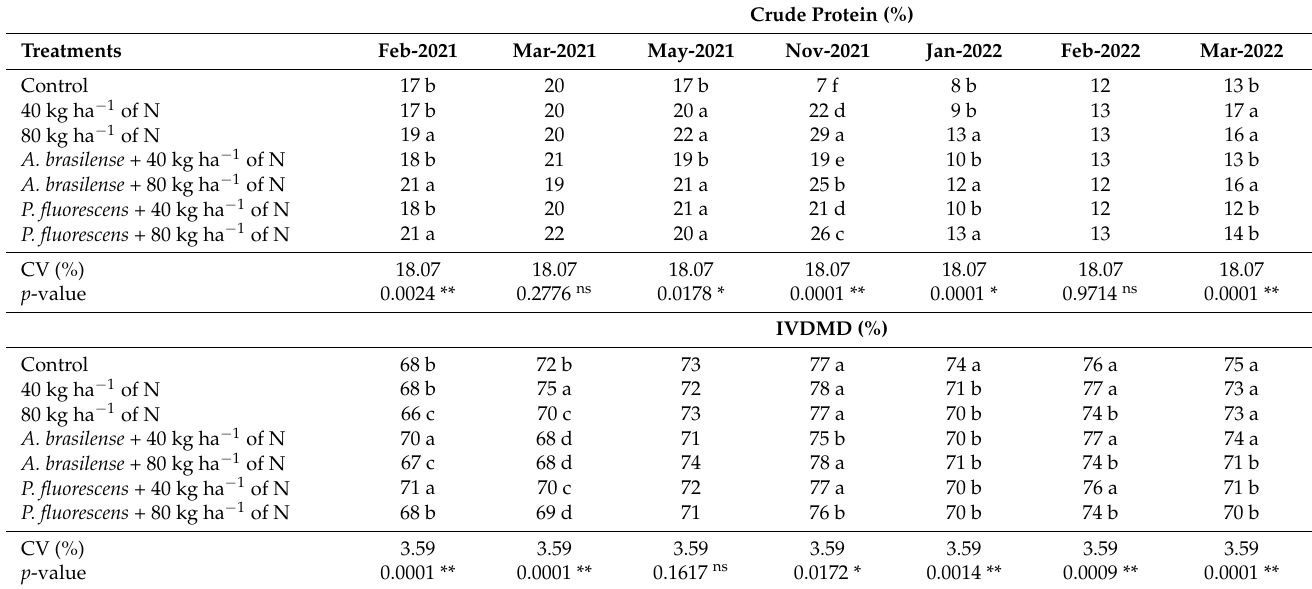
Table 6. Means of crude protein content of true in vitro dry matter digestibility (IVDMD) of Megath- yrsus maximus cv. BRS Zuri inoculated with PGPB.